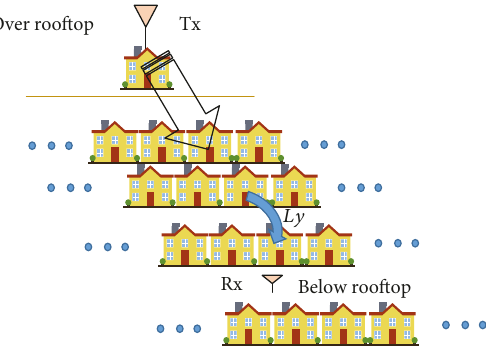
Figure 5: A case that houses are stuck together in the over rooftop